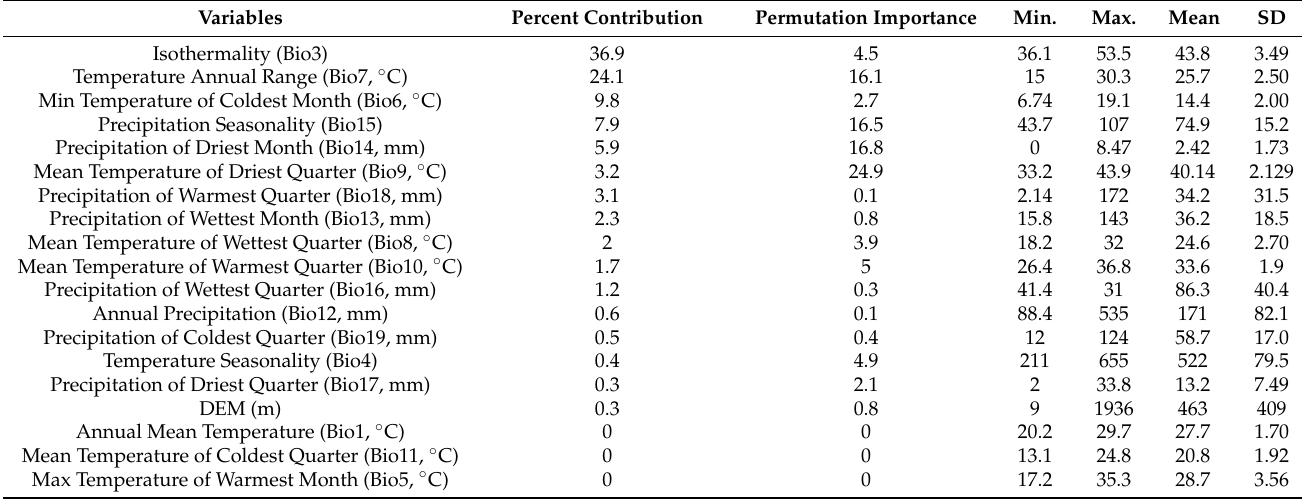
Table 2. The environmental variables considered in the 16SrII-B phytoplasma niche models and the average percent contributions of the environmental variables. The general statistics were calculated using occurrences ( n = 63). The bold variables are the most contributed bioclimatic factors in the